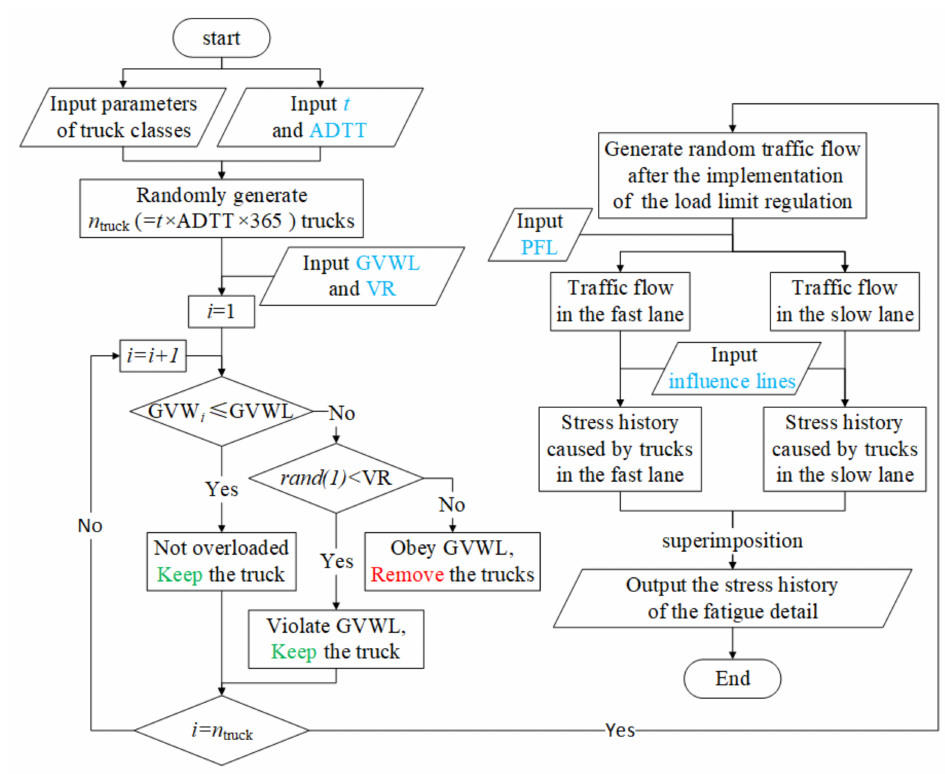
Figure 8. Flowchart of generating the stress history of the fatigue